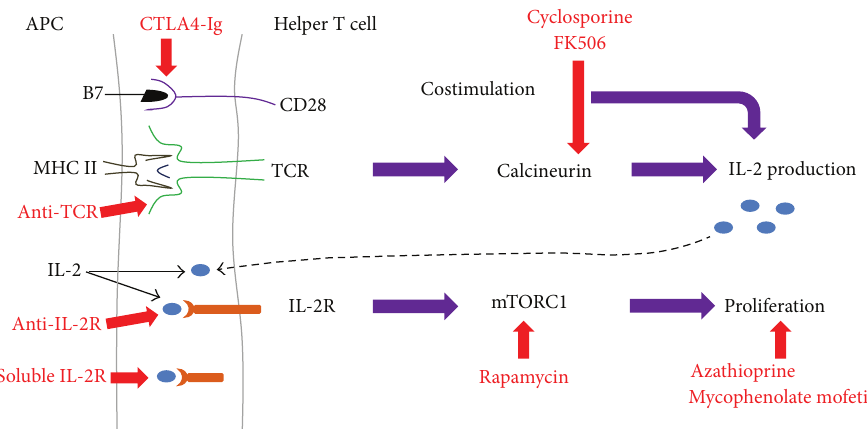
Figure 4: Points of action of immunosuppressive drugs. Various types of immunosuppressive drugs are shown in red and their targets are indicated by red arrows. In this example, we are showing the interaction of T cell receptor (TCR) proteins with MHC II-peptide complexes on the surface of antigen presenting cells (APC). TCRs also bind to MHC I-peptides on CD8 + T cells. The TCR signal is enhanced by the binding of B7 on the surface of APCs to CD28 on T cells. The binding of IL-2 to its receptor (IL-2R) on T cells results in proliferation and differentiation of the T cells into effector and memory cells. Humans express a second form of IL-2R that is soluble in serum, because it is missing the transmembrane domain of Il-2R. Soluble IL-2R binds and reduces the serum levels of